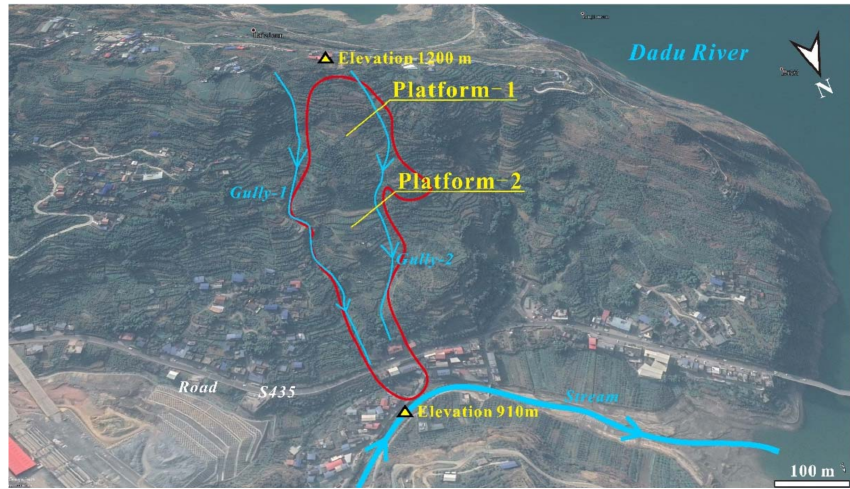
Figure 6. Topographic features of the area before the landslide. There are two platforms and two gullies in the landslide area.